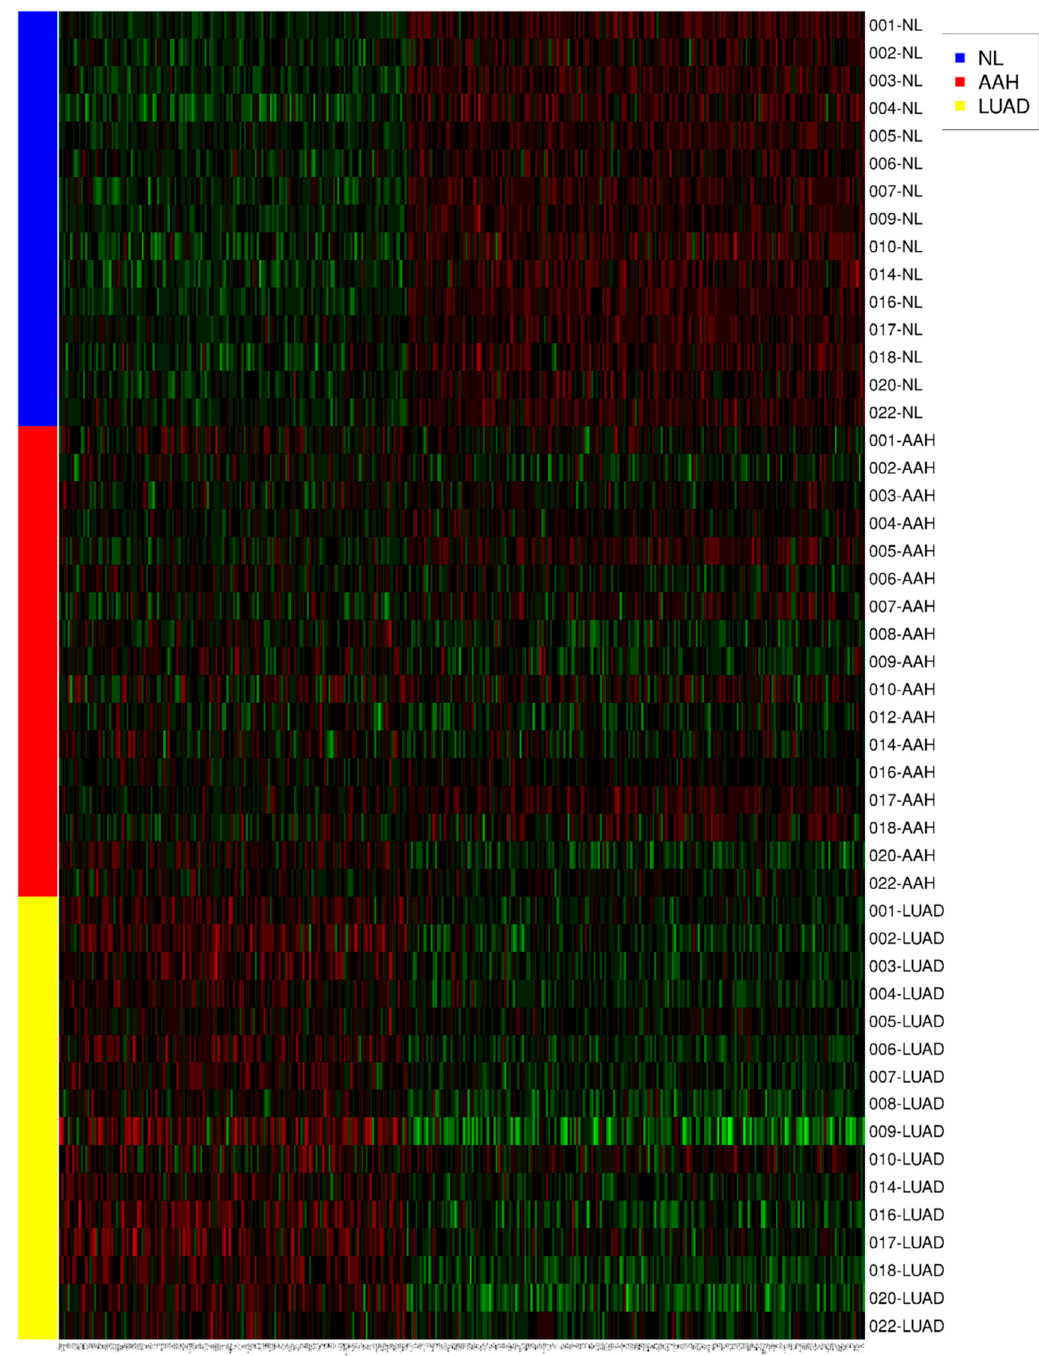
Figure 3. The heatmap demonstrates 372 expressed genes with the same or contrary trend as CAR (NL, AAH, LUAD). The gene expression level was colored red (upregulation), black (mean gene expression), and green (downregulation). The rows represent three groups of samples: normal lung parenchyma (NL, blue), atypical adenomatous hyperplasia (AAH, red), and lung adenocarcinoma (LUAD, yellow). The columns represent individual genes. This heatmap was drawn using the R package.